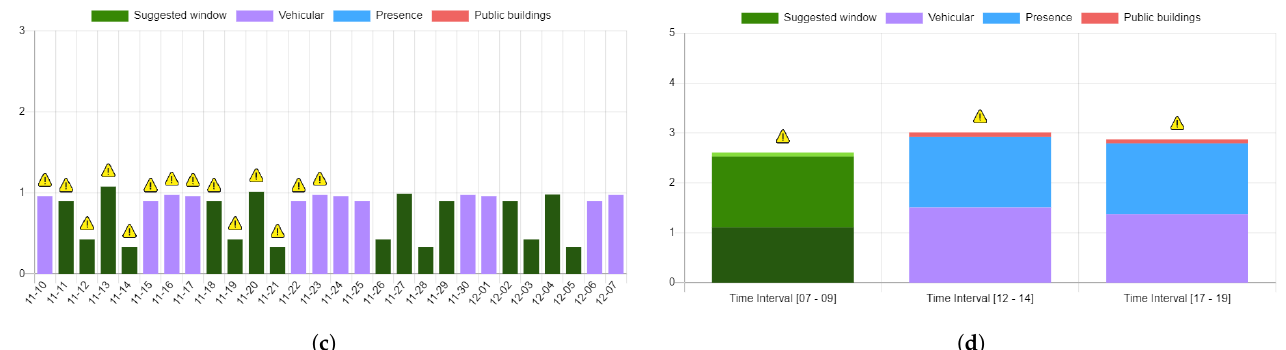
Figure 6. The UFM scheduler result, providing the operator with potential timeframes (green color) during which to schedule a specific maintenance operation. The final activity index is decomposed in all its constituent values, contributing to the final index. The analysis considers a period of one month, starting from 10 November 2021. ( a ) Equal cost timeframes proposed by the scheduler for a maintenance operation in Via Indipendenza X, Bologna, Italy. ( b ) Identified non-binding interference for a maintenance operation in Via Zamboni, Bologna, Italy, in the interval [10, 23]. ( c ) Equal cost timeframes, vehicular data only, proposed by the scheduler for a maintenance operation in Via Zamboni. ( d ) Scheduling of an urgent intervention in Via Zamboni, relying on the next-day prediction of the activity